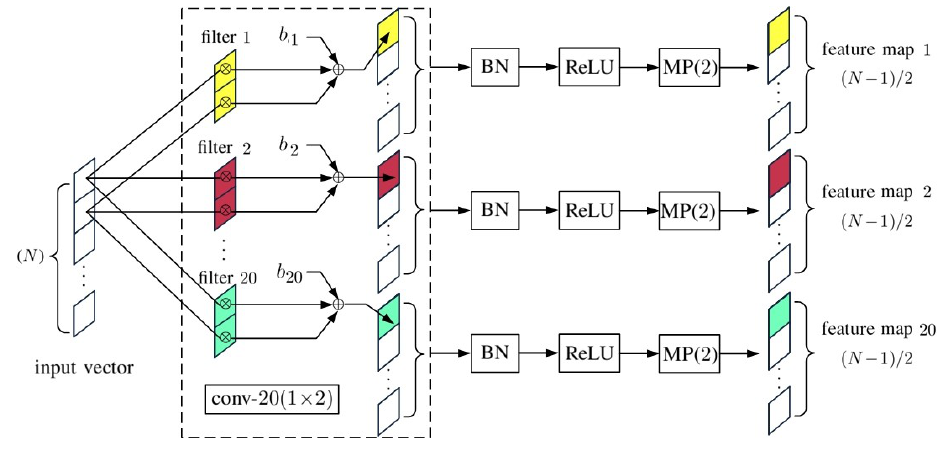
Figure 3. Schematic of convp-20 ( 1 × 2 )